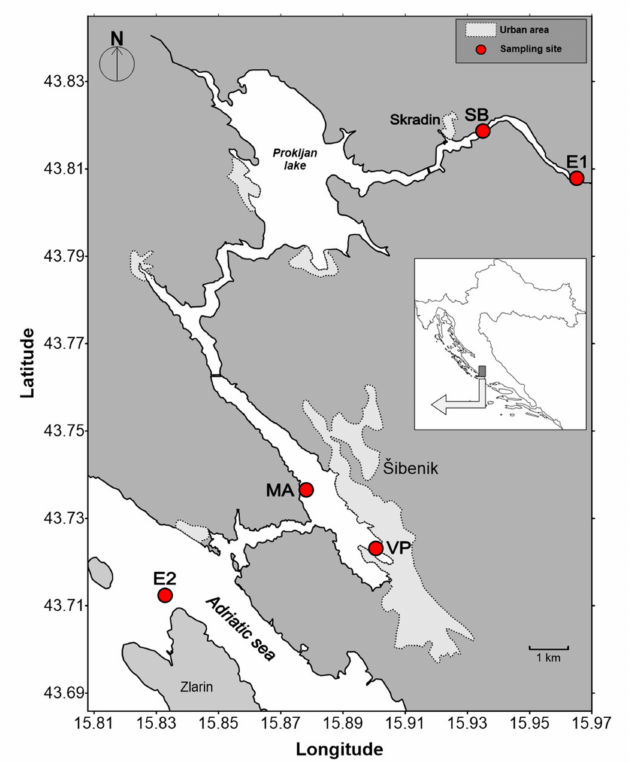
Figure 7. Map of the Krka River estuary with indicated sampling